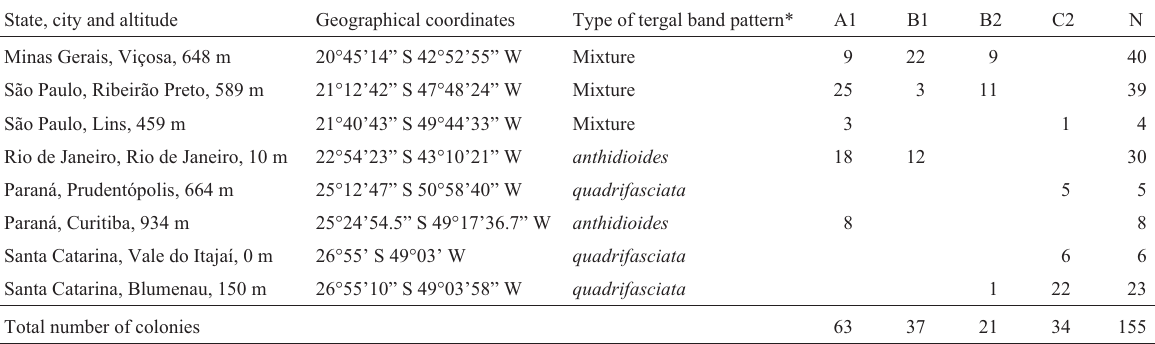
Table 1 - Number of colonies of Melipona quadrifasciata sampled, their geographical origin, subspecies identification based on tergal stripe patterns and the cytochrome b polymerase chain reaction restriction fragment length polymorphism (RFLP-PCR) composite haplotypes found. N = number of colo- nies for each